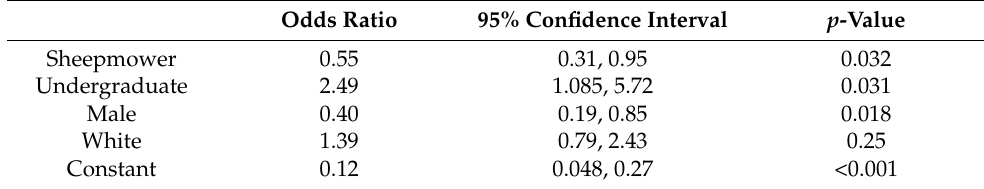
Table 4. Logistic Regression Results for Outcome: Currently Very Stressed/Stressed. Odds Ratio 95% Confidence Interval p -Value Sheepmower 0.55 0.31, 0.95